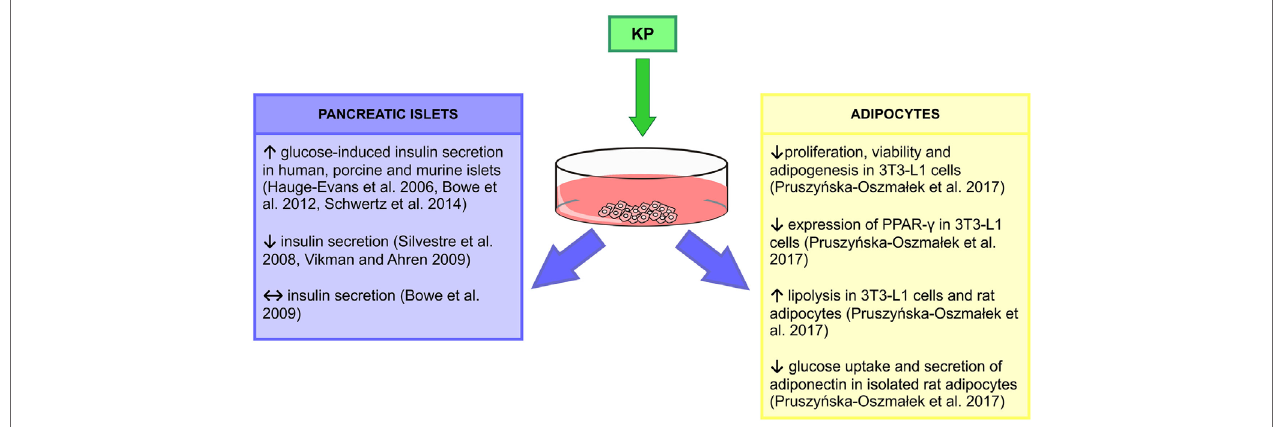
FigURe 2 | In vitro actions of kisspeptin (Kp). ↑ , increase; ↓ , decrease; ↔ , no effect (55, 63, 65,